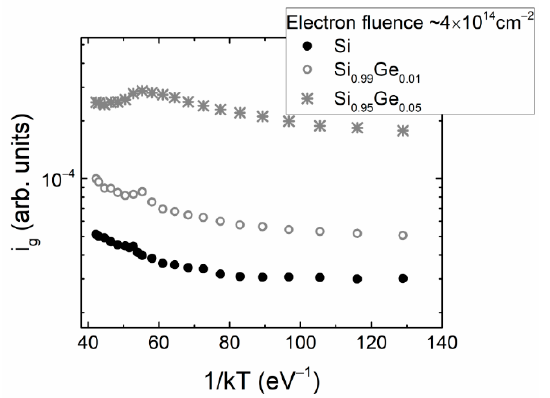
Figure 6. Generation current variations as a function of the inverse thermal excitation energy measured in samples under IR laser illumination.